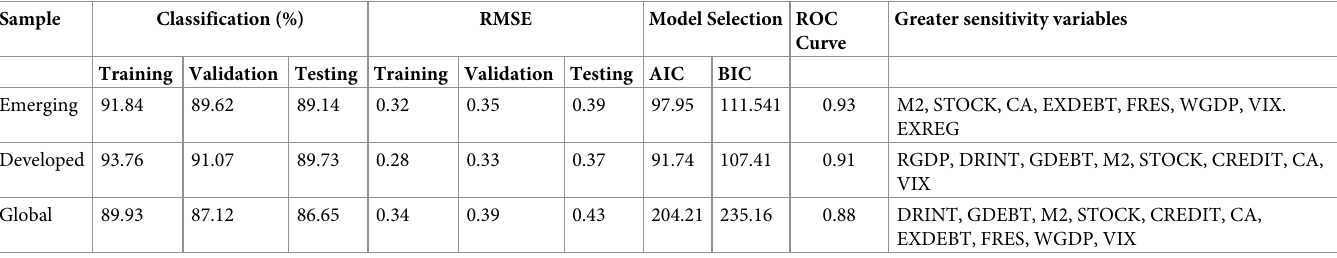
Table 9. Results of accuracy evaluation for SS2. Sample Classification (%) RMSE Model Selection ROC